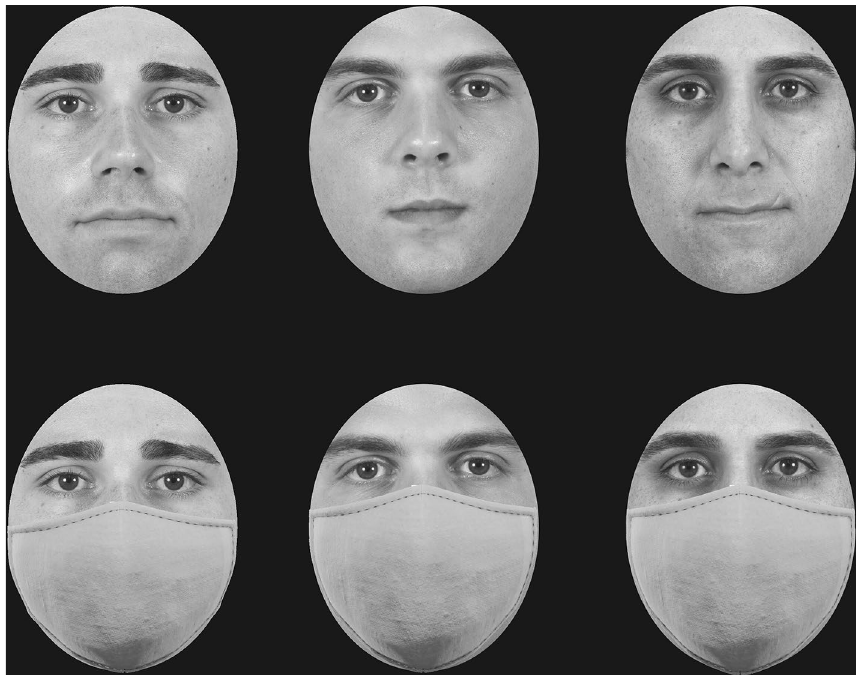
Figure 1. Examples of faces with and without masks similar to the ones used in the experiment. Faces are reproduced with premission from the Chicago Face Database 44